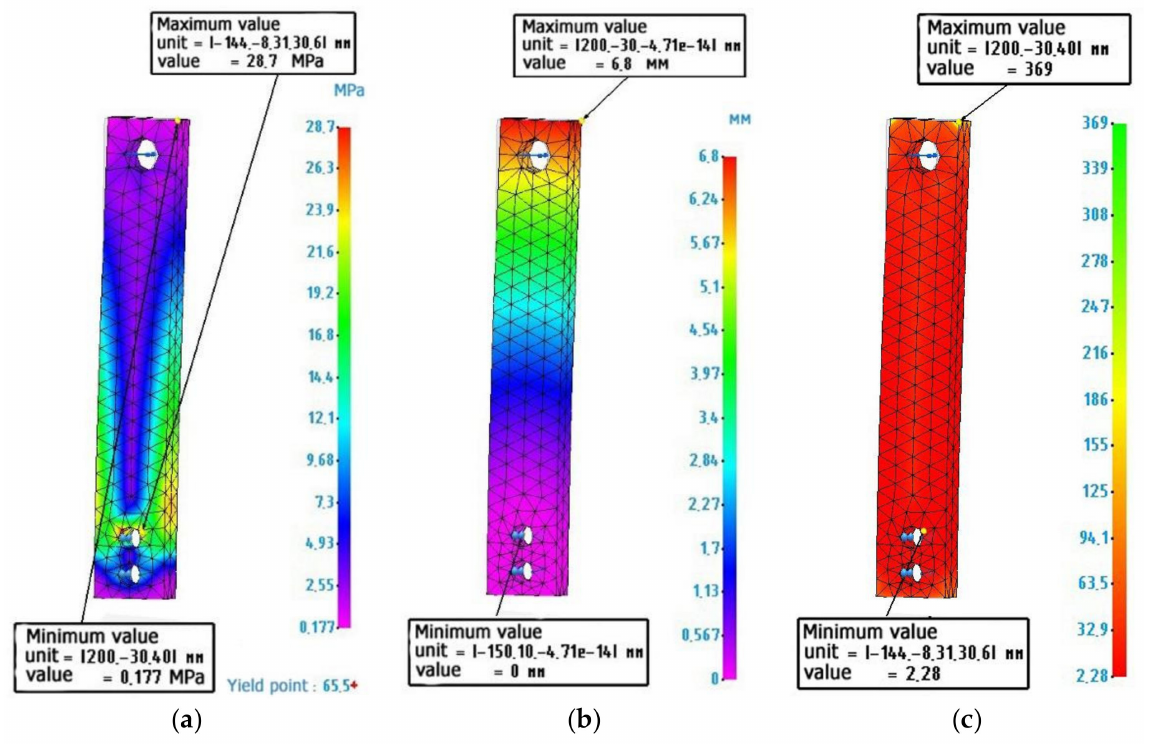
Figure 7. Finite element analysis of a metal-polymer sample: ( a ) Stress diagram according to von Mises, maximum value 28.7 MPa; ( b ) Strain diagram, maximum value 6.8 mm: ( c ) Safety factor diagram, minimum value 2.28.